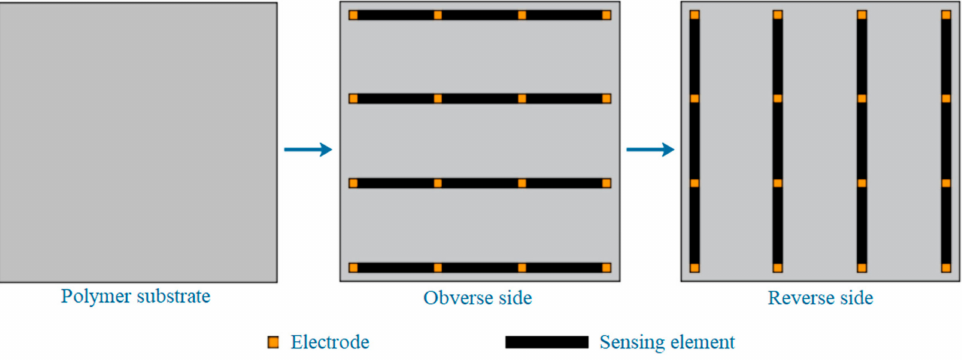
Figure 13. The composite mesh film